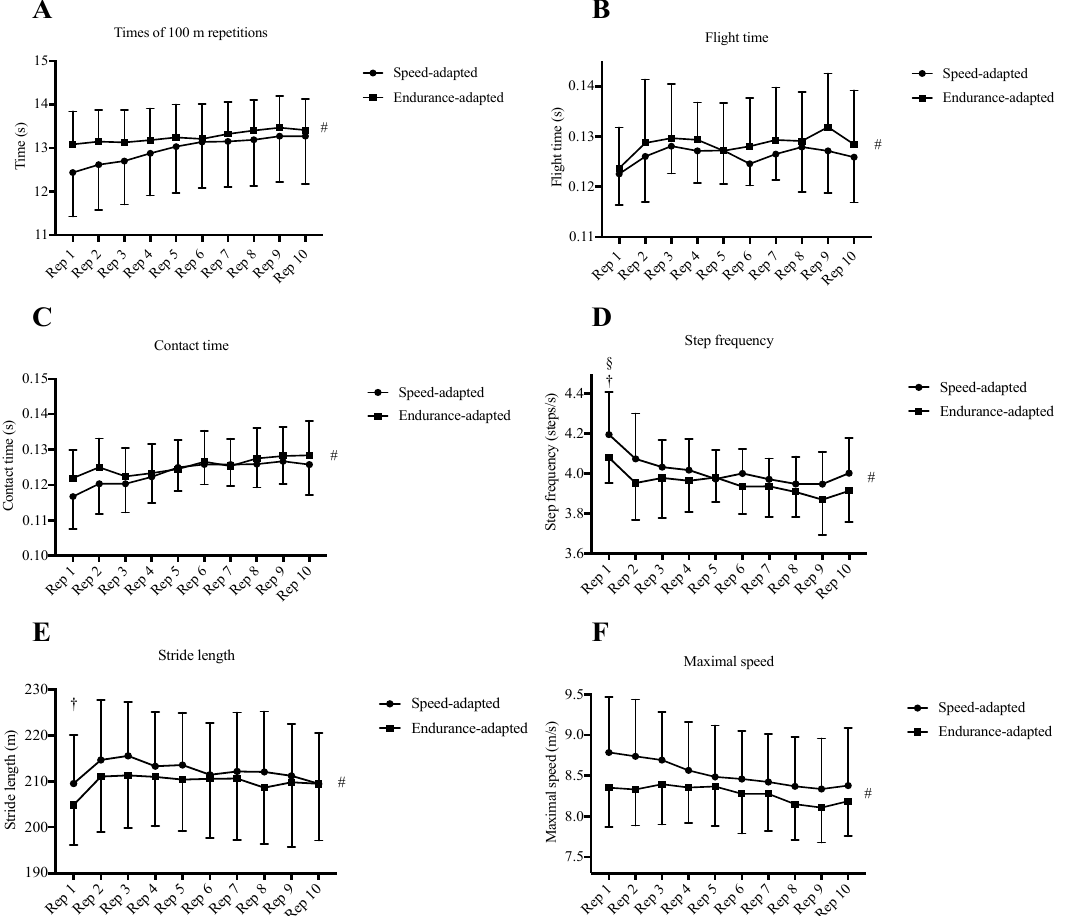
Figure 1. Mean ( ± SD) repetitions time ( A ), flight time ( B ), contact time ( C ), step frequency ( D ), stride length ( E ), and maximal speed of each repetition ( F ). † and § indicate the differences between successive repetitions ( p < 0.05, d ≥ 0.61) in speed- and endurance-adapted milers, respectively. # indicates main time effect.